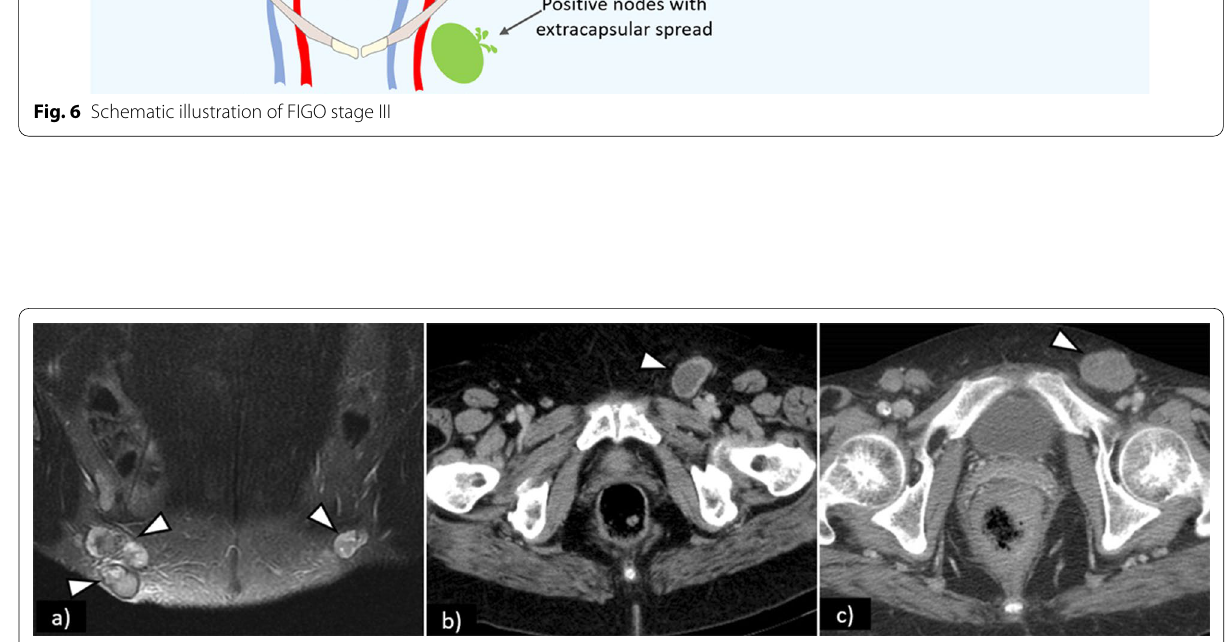
Fig. 7 Pathologically proven inguinofemoral lymph node metastasis in different patients (FIGO III): a coronal fat saturation T2WI shows bilateral enlarged heterogeneous lymph nodes with necrotic changes depicted by intra‑nodal high‑signal intensity areas; b axial CT shows left inguinofemoral enlarged node with low‑attenuation necrotic centre; c axial CT shows heterogeneous enlarged left inguinofemoral